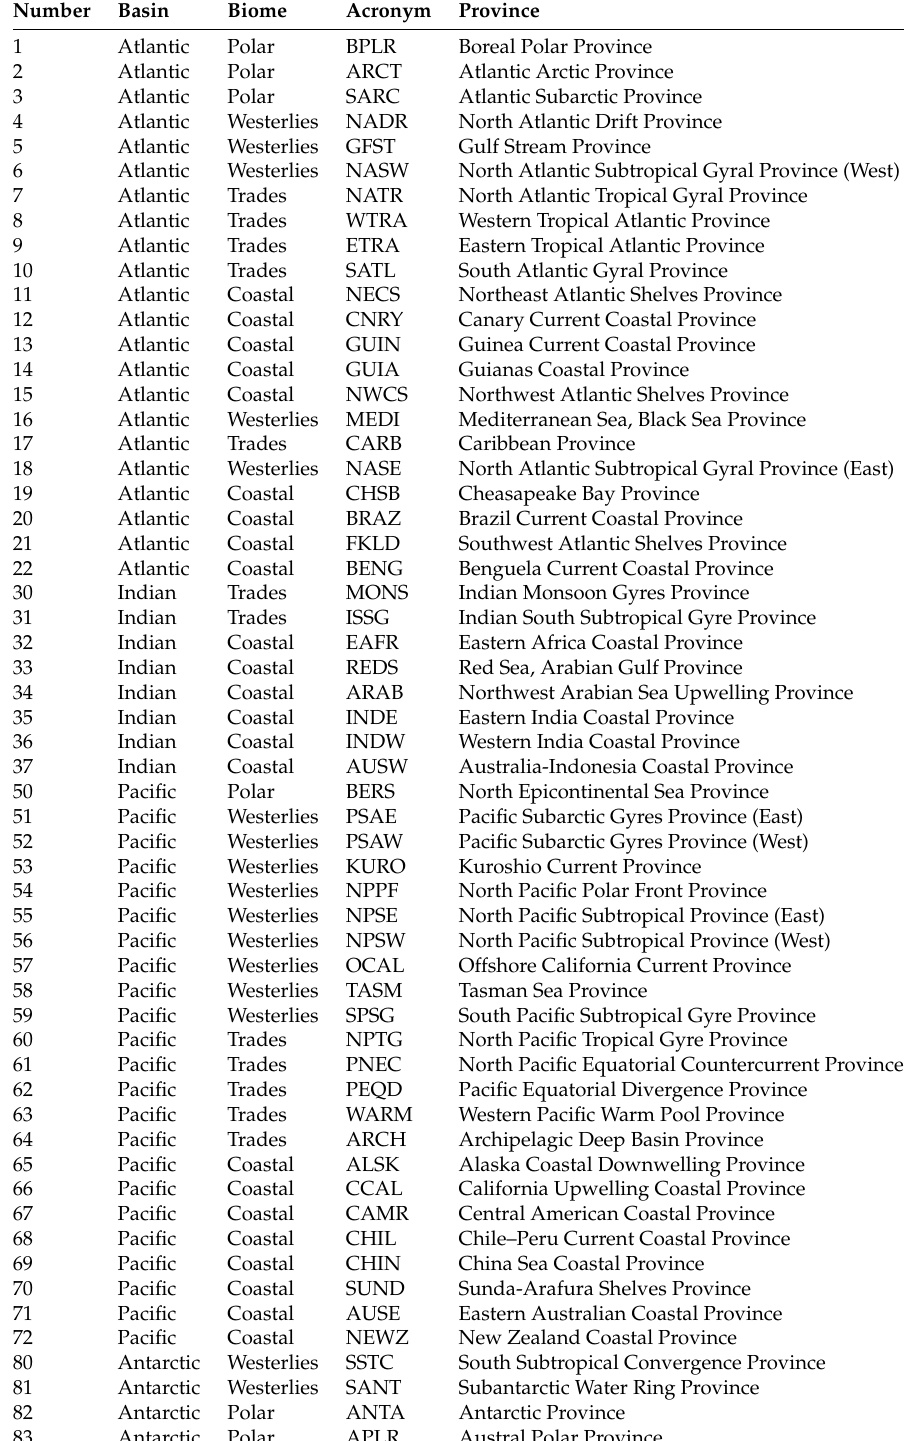
Table A1. List of biogeographic provinces according to Longhurst